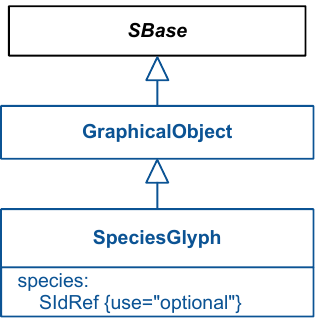
Figure 11: The definitions of the SpeciesGlyph